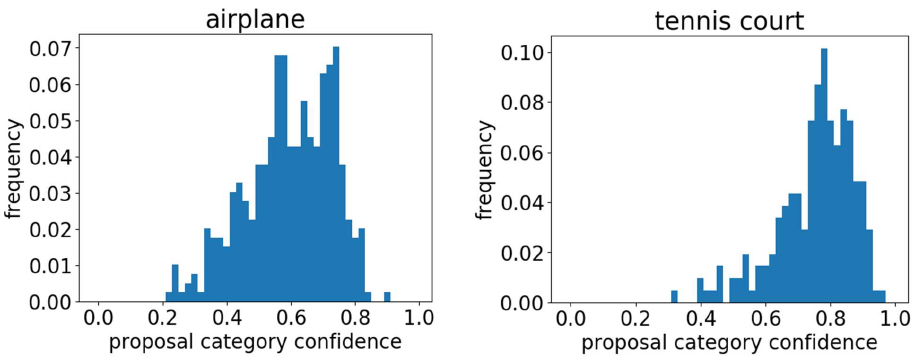
Figure 5. Frequency histogram of confidence for the airplane ( left ) and tennis court ( right